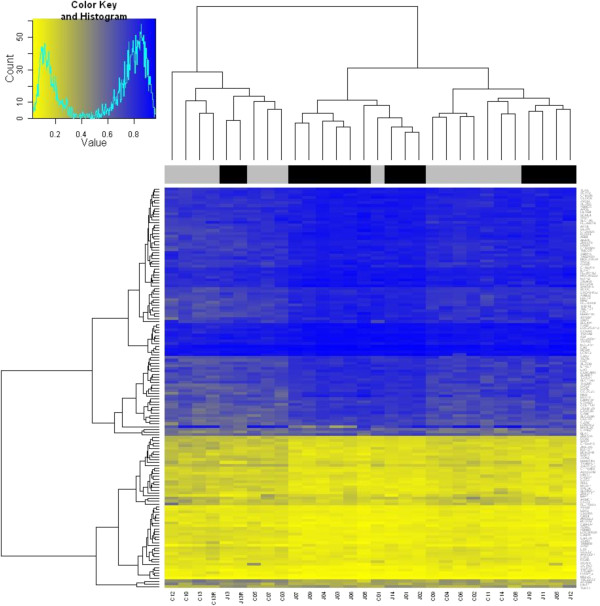
Heatmap of significantly differentially methylated loci between JIA cases and controls. Black = case, Grey = control. ‘Value’ = percent methylation.